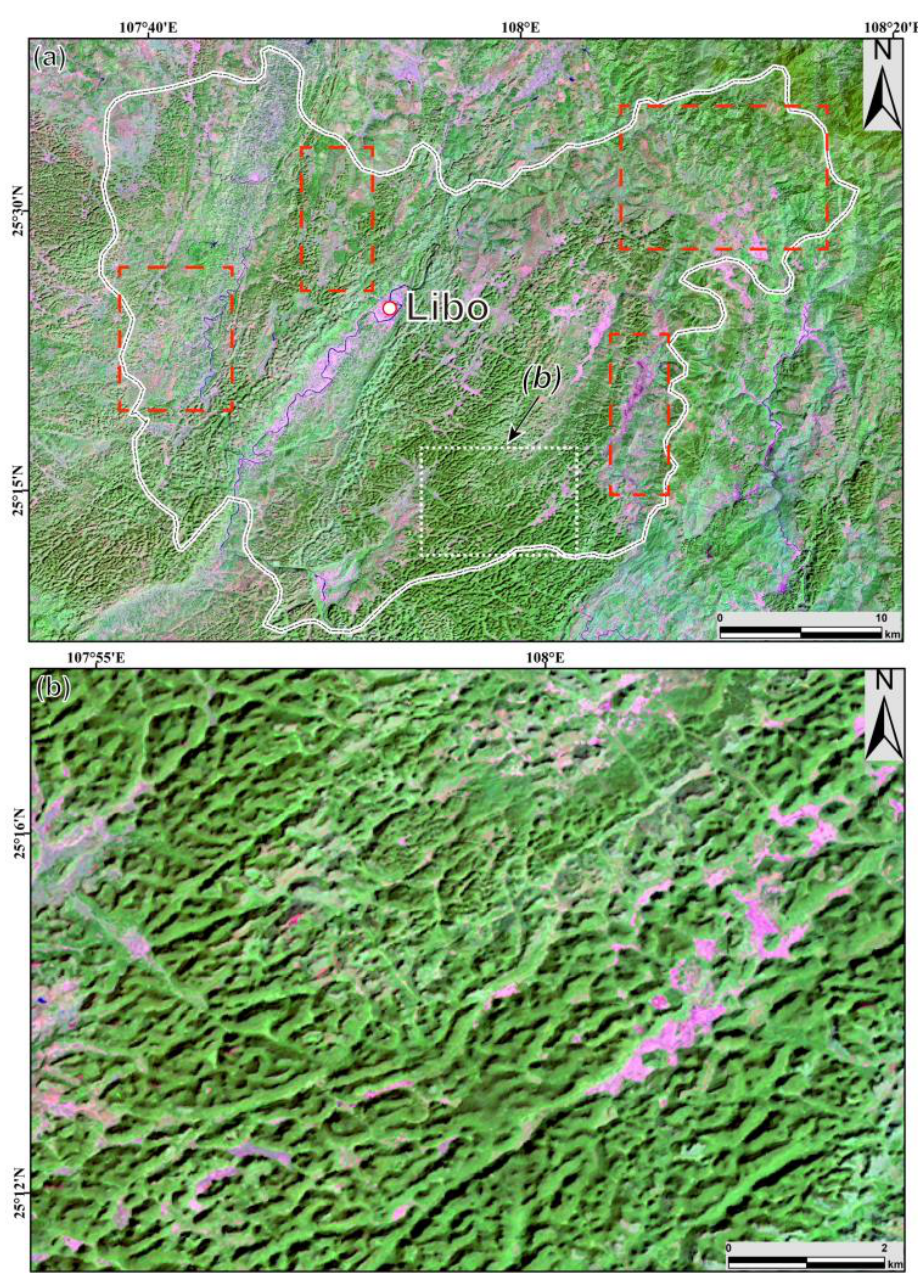
Figure 3. ( a ) Landsat 8 OLI image (RGB as 753) showing the geomorphological landscapes and vegetation of Libo area. ( b ) The sub-image corresponding to the area marked by the white dashed- line rectangle in ( a ) displaying typical peanut shell-like structure of the cone karst landscape in the study